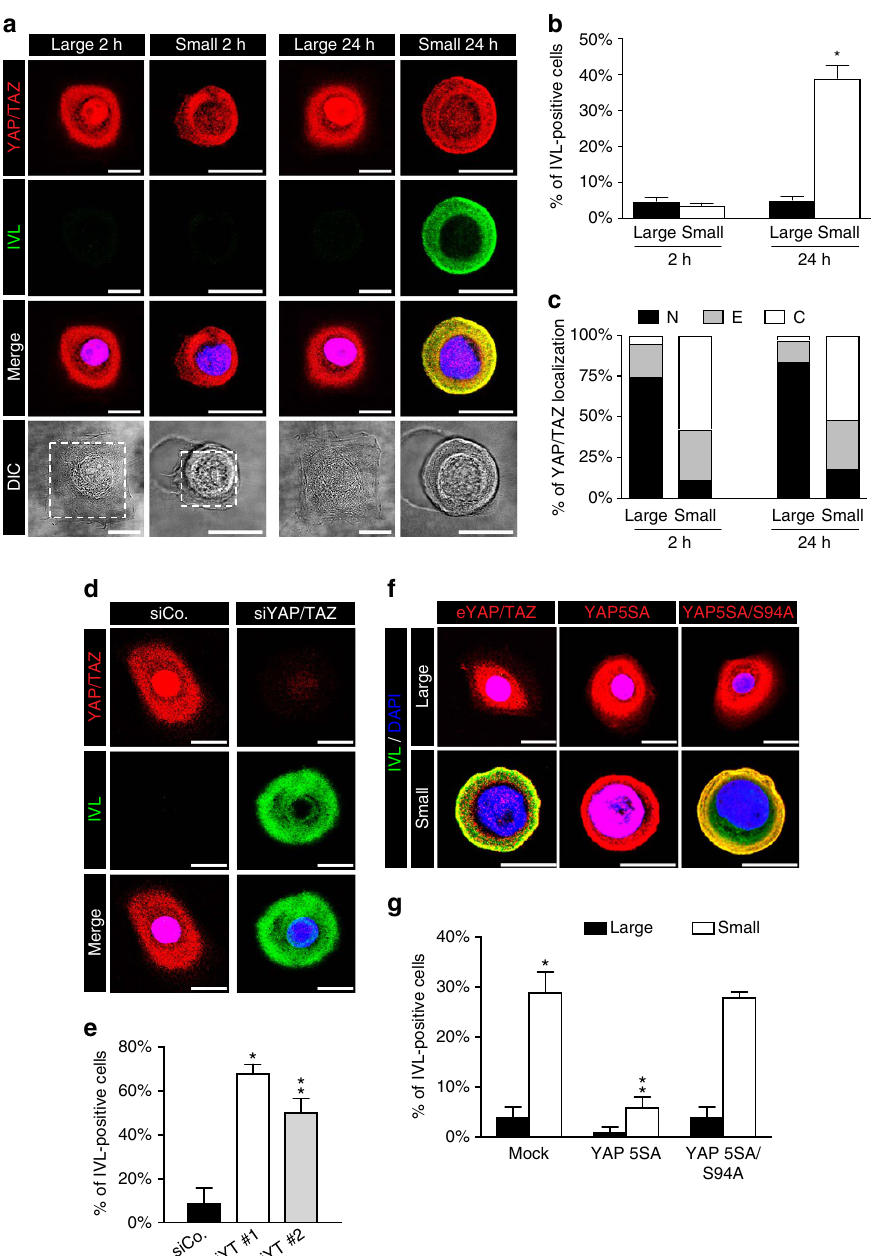
Figure 1 | Controlling cell shape regulates the fate of individual epidermal SCs through YAP/TAZ. ( a ) Confocal IF (top) and bright field images (bottom) of neonatal human epidermal keratinocytes (nHEK) plated as individual cells on square microprinted fibronectin islands of 1,024 m m 2 (large) or 300 m m 2 (small). Cells were stained for endogenous YAP and TAZ proteins (red) and Involucrin (IVL, green). DAPI (blue) is a nuclear counterstain. Scale bar: 20 m m. Dotted lines highlight microprinted fibronectin islands. ( b ) Quantitation of differentiation of experiments shown in a . Bars represent mean þ s.e.m. (* P o 0.0001, compared to cells on large at 24h; Student’s t -test). ( c ) Proportion of nHEK cells displaying preferential nuclear YAP/TAZ localization (N, black), even distribution of YAP/TAZ in nucleus and cytoplasm (E, grey) or cytoplasmic YAP/TAZ (C, white). ( b , c ) Data from at least three independent experiments. ( d ) nHEK cells were transfected with control siRNA (siCo.) or with two independent sets of siRNAs against YAP and TAZ mRNAs (siYT #1, siYT #2, see Supplementary Data 2). Staining as in a . Scale bar: 20 m m. ( e ) Quantitation of differentiation of nHEK cells treated as in d . Bars represent mean þ s.d. ( n ¼ 3 independent experiments. * P o 0.0001, ** P o 0.001, compared to siCo.; Student’s t -test). See also Supplementary Fig. 2a for western blot analysis of nHEK differentiation and Supplementary Fig. 2b for the effect of YAP/TAZ knockdown on keratinocyte proliferation. ( f ) nHEK cells were infected either with an empty vector (Mock) or with the indicated doxycycline-inducible lentiviral YAP constructs. After 24h, cells were replated on either small or large fibronectin islands, induced with doxycycline for additional 24h and finally analysed. Confocal images show representative staining for either endogenous YAP/TAZ proteins in Mock-infected cells or the HA-tagged YAP constructs (red), merged with Involucrin (green) and DAPI (blue). Scale bar: 20 m m. See Supplementary Fig. 1d for HA-tag background staining on Mock-infected control cells. ( g ) Quantitation of differentiation of experiments shown in f . Bars represent mean þ s.d. ( n ¼ 3 independent experiments. * P o 0.0001 compared to Mock-infected cells plated on large, ** P o 0.001 compared to Mock-infected cells plated on small; Student’s t -test).